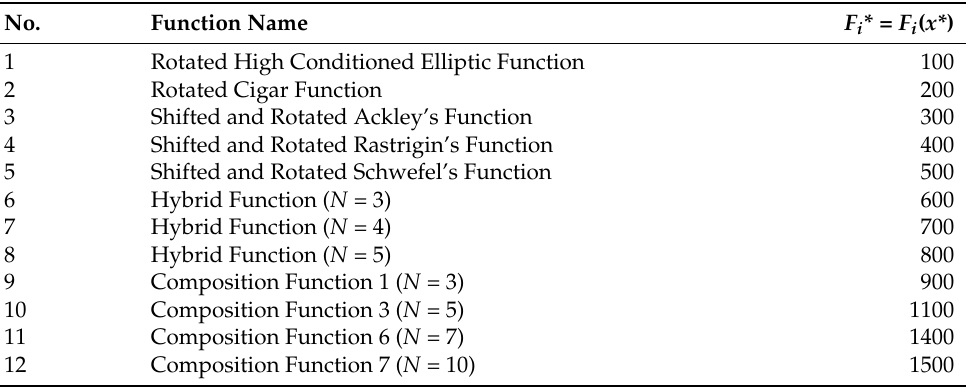
Table 2. The 12 CEC2015 benchmark functions.